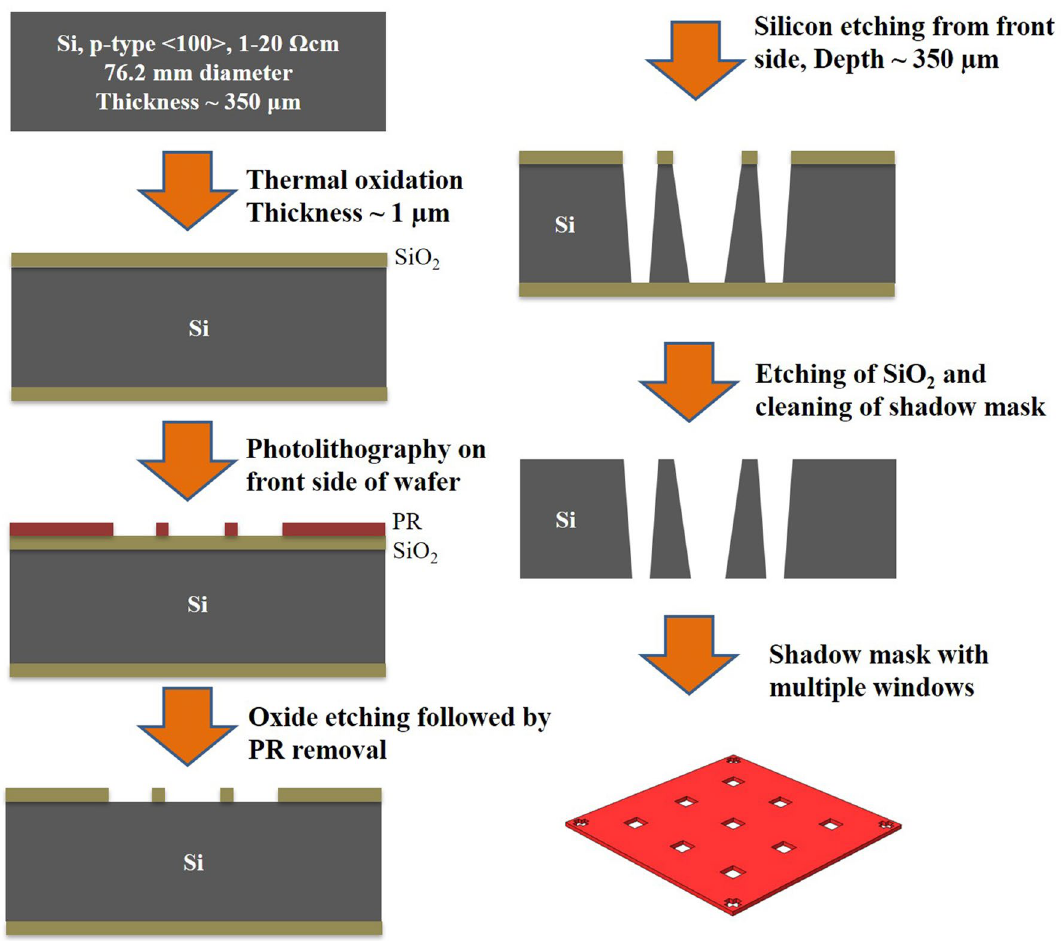
Figure 1. Schematic of a silicon shadow mask showing the windows, which are used to fabricate 3 × 3 array of devices over a single